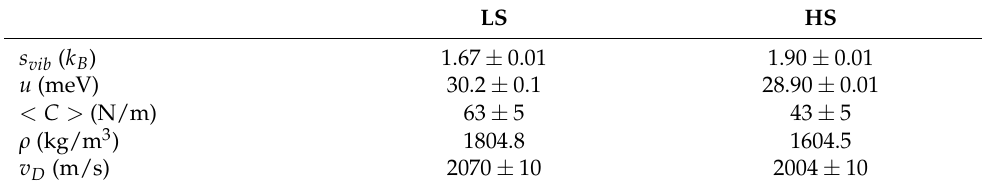
Figure 2. ( a ) Partial vDOS spectra of the simulated bulk material in the HS (red) and the LS (blue) states. ( b ) g ( E ) / E 2 as a function of E for the two spin states. The lowest energy part of the curves (black lines) corresponds to the range where the Debye approximation is valid [32]. Table 2. Physical quantities extracted from the partial vDOS spectra of the bulk material in the HS and the LS states using the methods described in reference